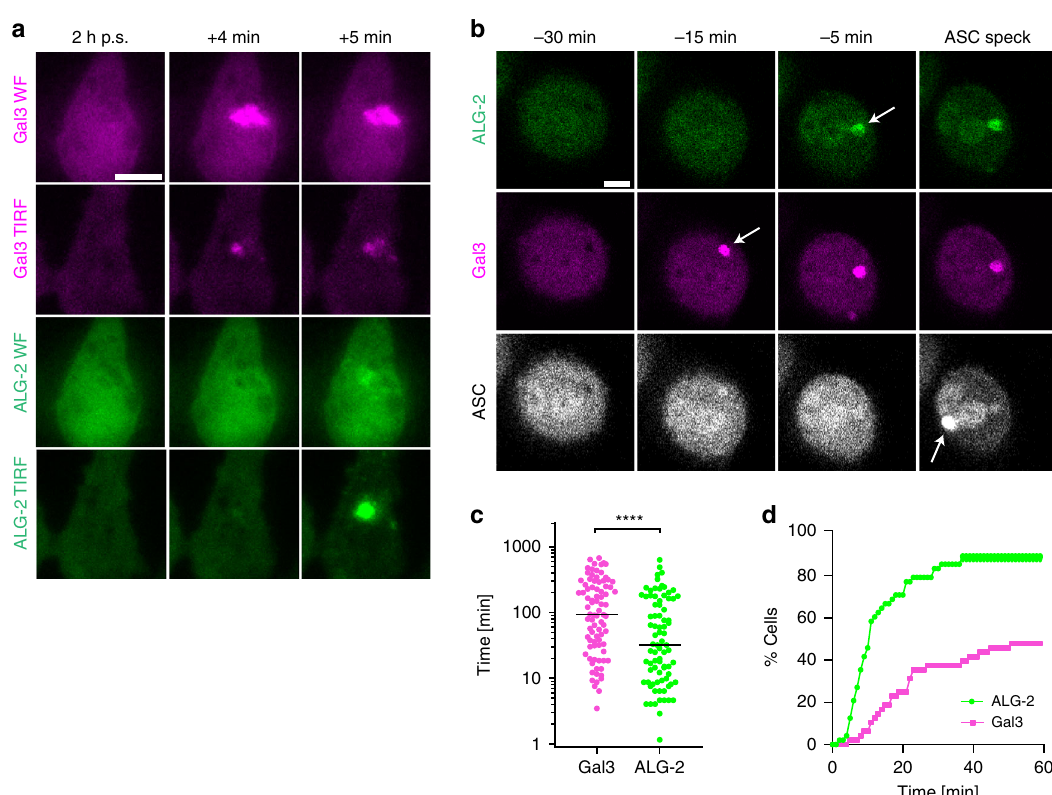
Fig. 8 Plasma membrane damage by silica activates the NLRP3 in fl ammasome. THP-1 cells with ALG-2 (green), Gal-3 (magenta) and ASC (grey) were infected by Mtb-BFP (blue) and imaged live for up to 24 h. a Representative time-lapse images of ALG-2 and Gal-3 from wide- fi eld (WF) and TIRF imaging during treatment with silica (time indicated post addition of silica, p.s.). b Representative time-lapse images of ASC-speck formation during treatment with silica. Arrows indicate ALG-2, Gal-3 and ASC speck events. c Timing of Gal-3 and ALG-2 events compared with ASC-speck formation after silica treatment. n = 82 ALG-2 and n = 85 Gal-3 events analysed from three independent experiments. Lines indicate median values. **** p < 0.0001 by two- sided Mann – Whitney test. d Quanti fi cation of the percentage of cells with ALG-2 or Gal-3 events in the given time interval before ASC-speck formation. n = 48 cells from three independent experiments. All images are representative of three independent experiments. Scale bars 10 µ m. Source data are provided as a Source Data fi